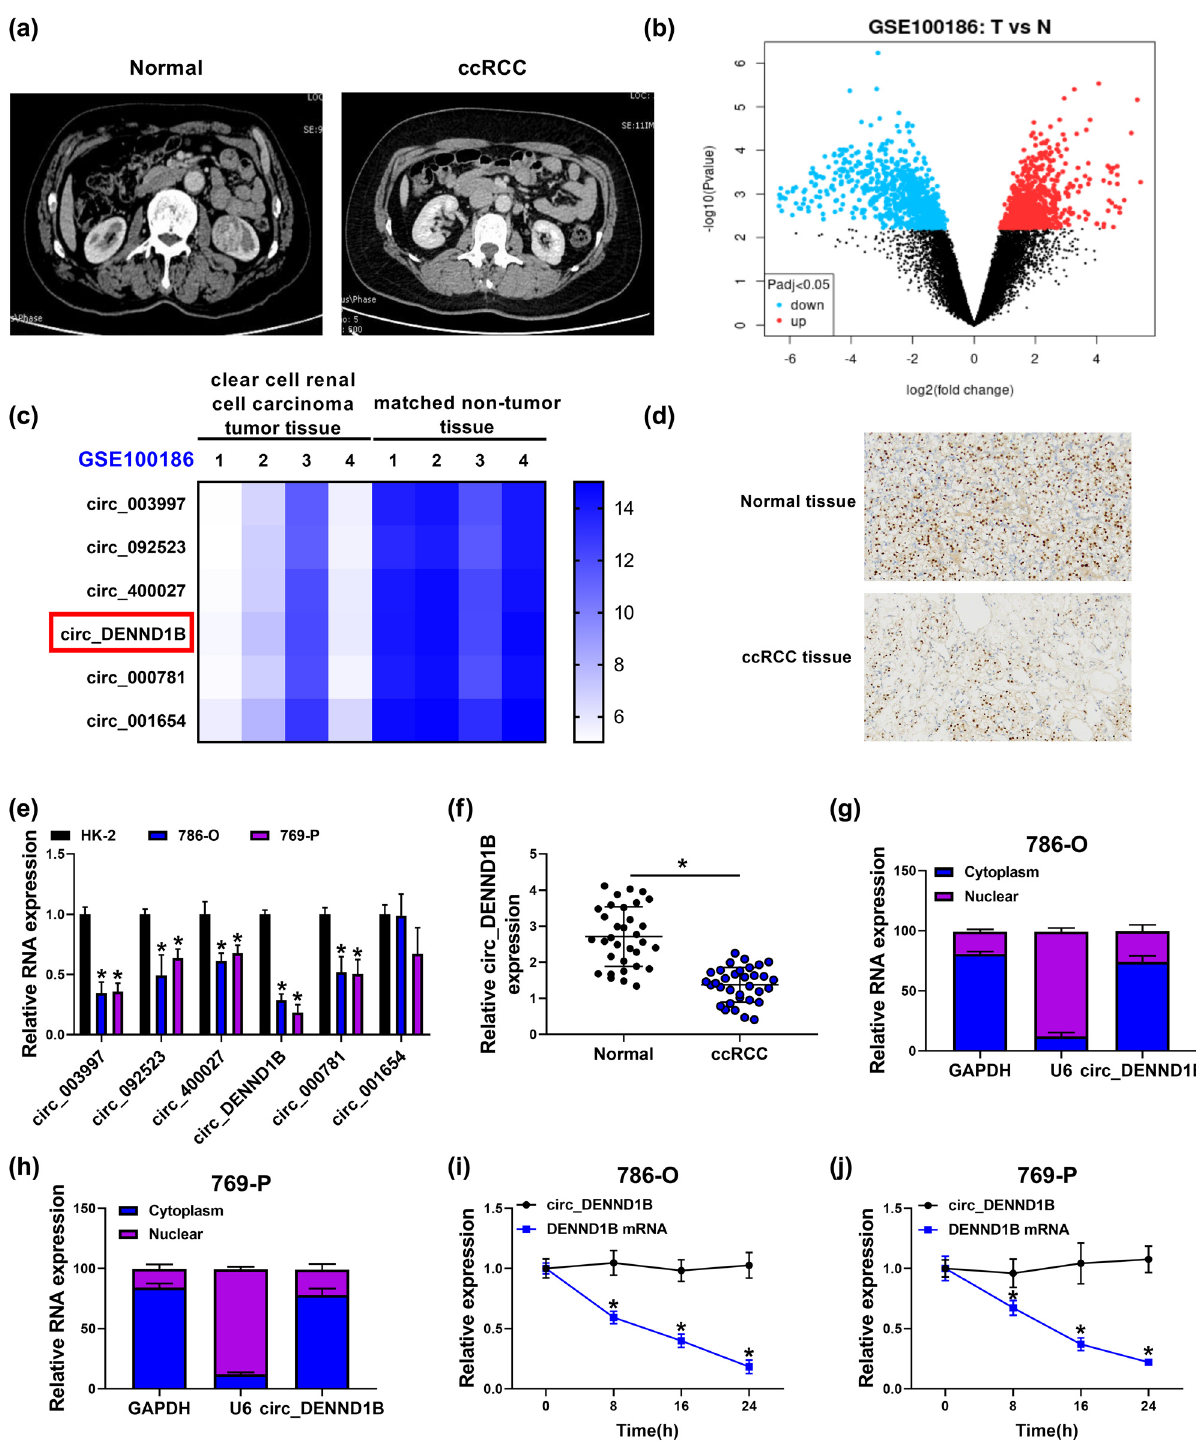
Figure 1: circ_DENND1B was downregulated in ccRCC. ( a ) Computed tomography scan of ccRCC tissues and normal tissues. ( b and c ) GSE100186 data were used to analyze the di ff erential expression of circRNAs in renal cancer tissues. ( d ) IHC detected the positive cell rate of Ki67 in ccRCC tissues. ( e ) qRT - PCR detected the relative circRNA expression. ( f ) qRT - PCR detected the expression of circ_DENND1B in ccRCC cells. ( g and h ) The distribution of circ_DENND1B in nucleus or cytoplasm was determined by qRT - PCR. ( i and j ) Act D treated 786 - O and 769 - P cells and qRT - PCR detected circ_DENND1B and DENND1B mRNA levels. * P <